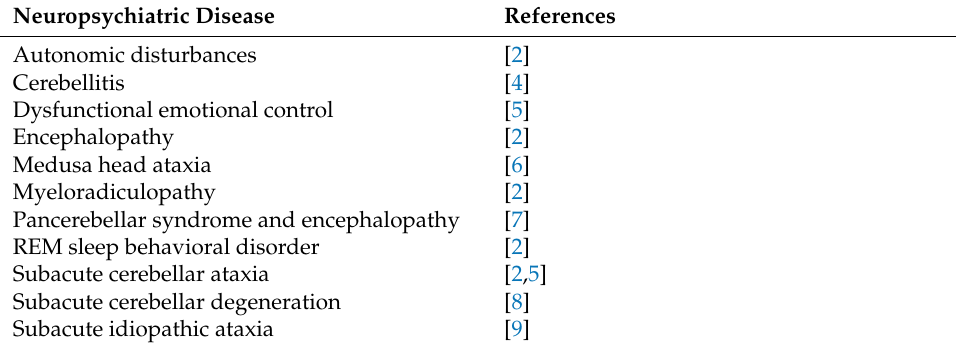
Table 1. Homer-3 autoantibodies in neuropsychiatric disease: case report and series. Neuropsychiatric